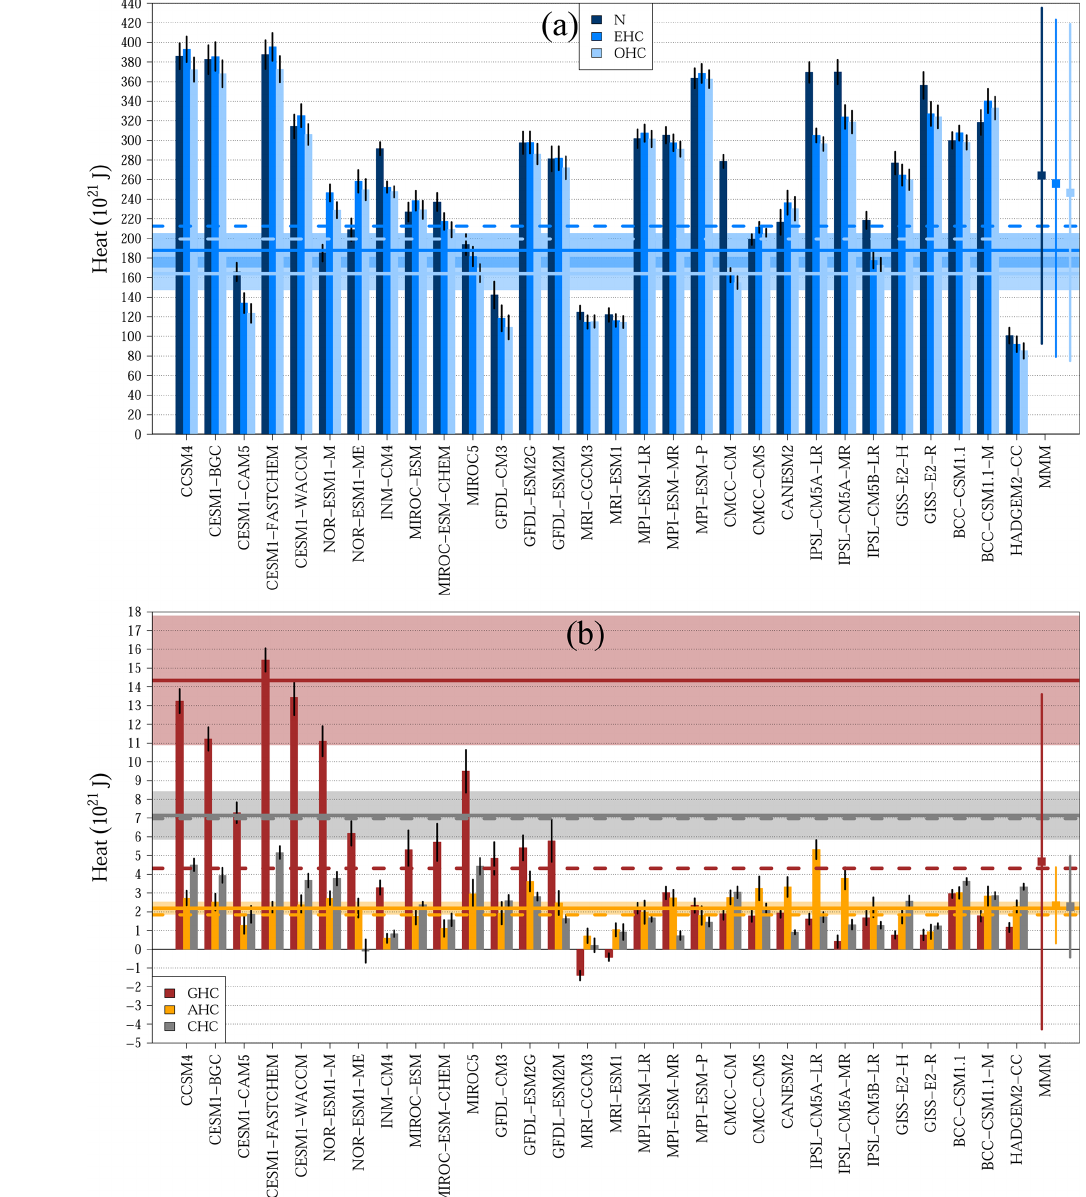
Figure 2. Simulated heat storage for 1972–2005CE from 30 CMIP5 GCM Historical simulations. (a) Results for N (dark blue bars), EHC (blue bars) and OHC (light blue bars). (b) Results for GHC (brown bars), AHC (orange bars) and CHC (grey bars). Vertical black lines at the top of the bars indicate the 95% confidence interval for each model. Observations from von Schuckmann et al. (2020) are shown as solid horizontal lines and shadows (mean and 95% confidence intervals), and observations from Church et al. (2011) are displayed as dashed horizontal lines. Multimodel means and 95% confidence intervals are indicated in the right side of the panel